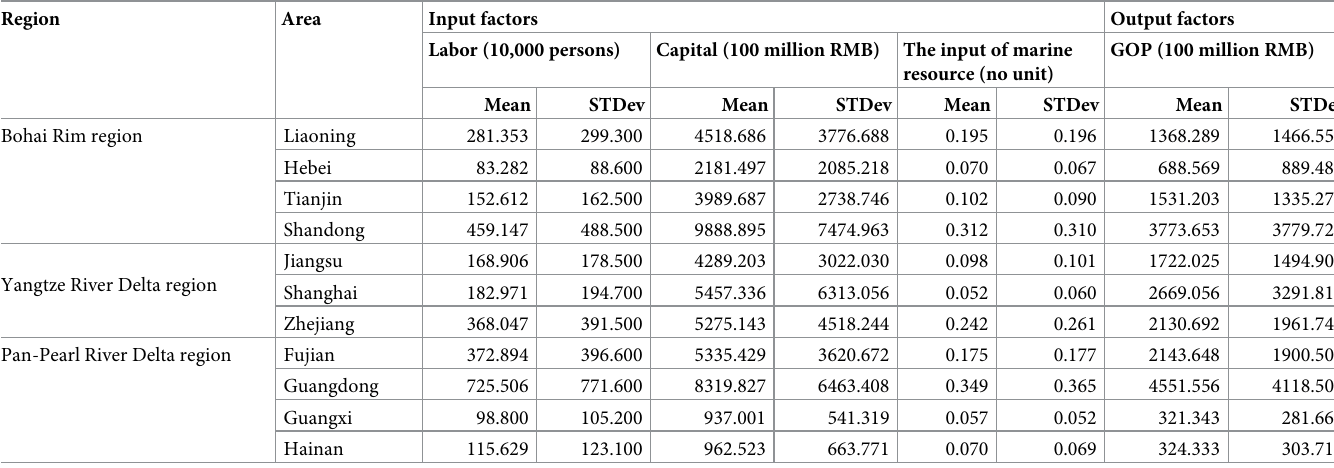
Table 2. Summary statistics of input and output factors by area (2000–2016).